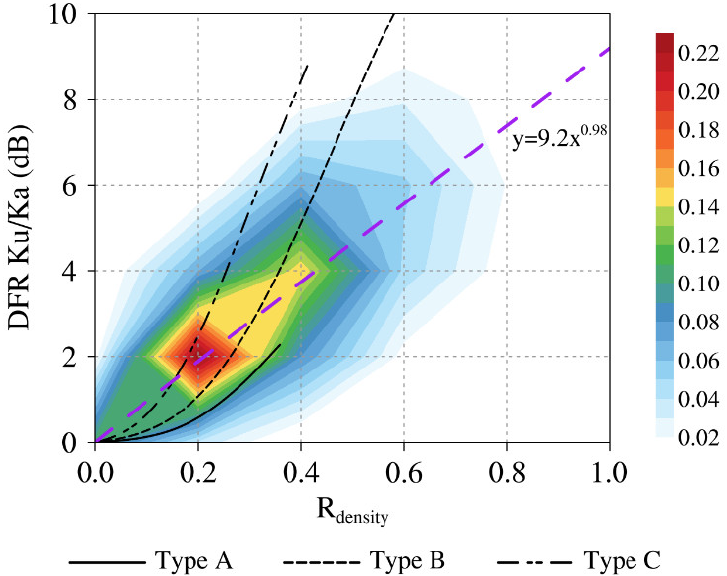
Figure 7. Relation between DFR Ku/Ka and R density for modeled (lines) and observed (shading) results. Shading represents the normalized occurrence frequencies. Purple line is obtained from linear regression between log 10 (R density ) and log 10 (DFR Ku/Ka) for observed results.